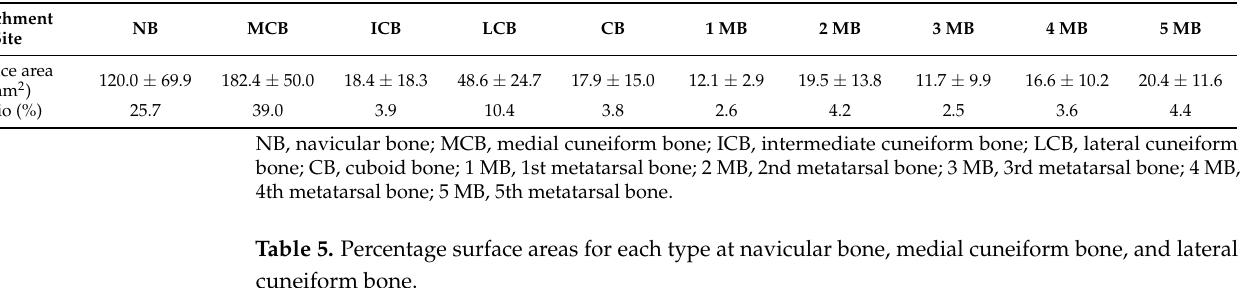
Table 4. Surface areas at sites of tibialis posterior tendon attachment.